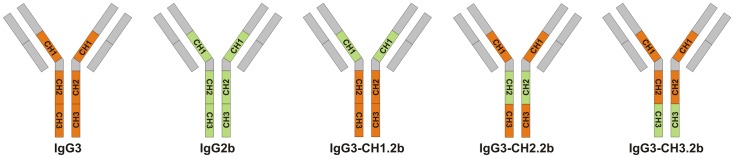
Nomenclature and construction of heavy-chain hybrids of mAb F26G3.The CH1, CH2 and CH3 domains of IgG3 mAb were replaced with the respective domains of the IgG2b subclass switch variant of mAb F26G3.